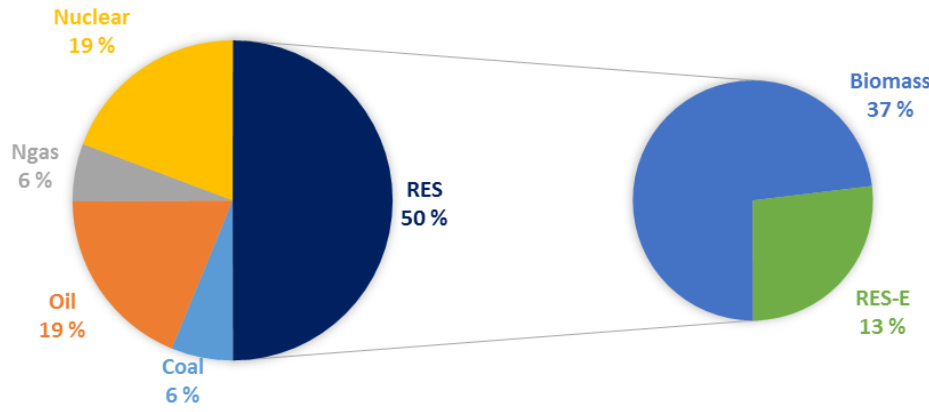
Figure 23. Fuel consumption in the Finnish scenario with 50% RES.